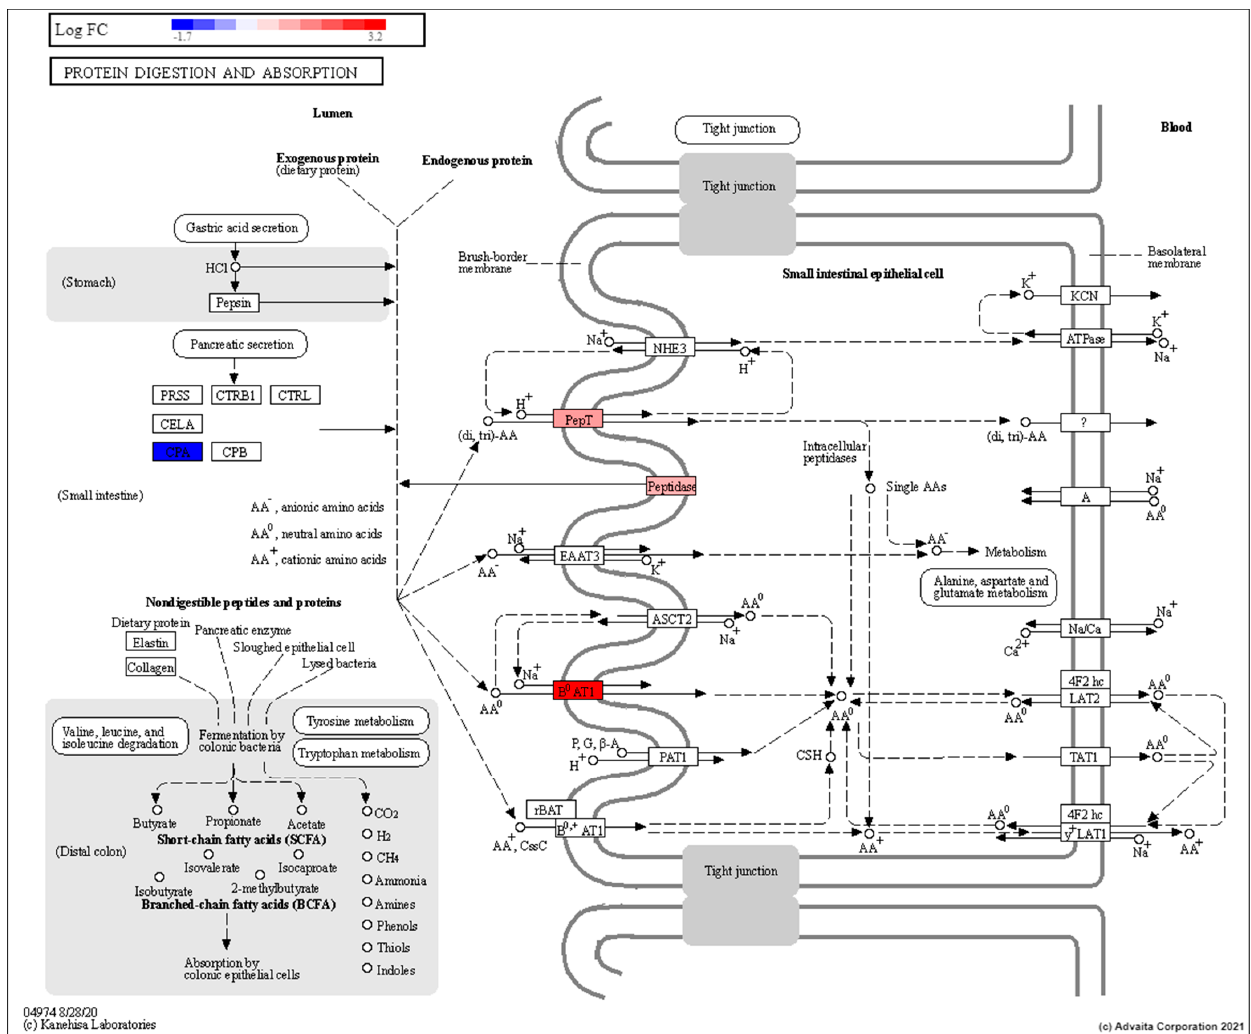
Figure 6. Topological diagram of the protein digestion and absorption pathway showing the upregulation (28.5-Rad vs 28.5-Ctrl) of peptidases and amino acid transporters on the brush border membrane in response to low dose radiation exposure RED: upregulated, BLUE: downregulated.